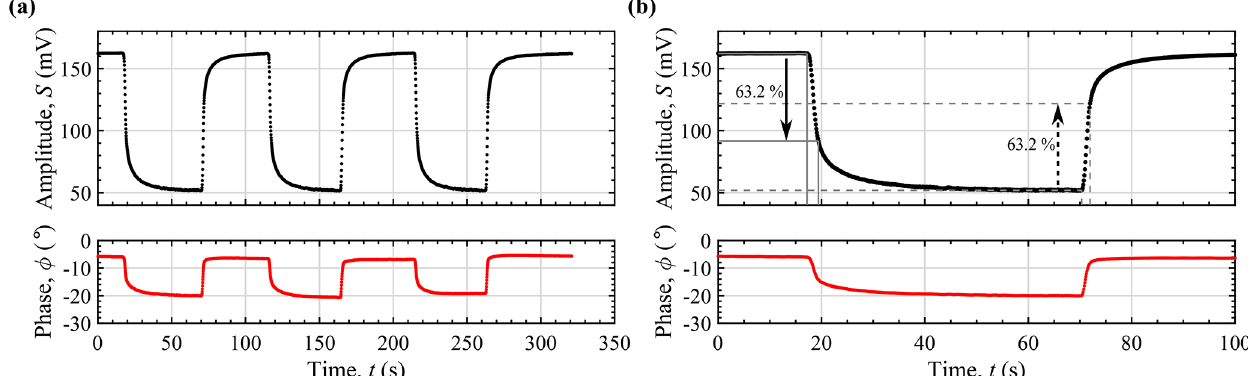
Figure D1. (a) Background corrected photoacoustic amplitude and phase during a sequence of recovery and response time measurements, performed by alternately sampling humidified and ambient air with water vapor mole fractions of 18750 and 5570ppm, respectively. A lock-in integration time of 1s was used. (b) First segment of (a) with indicated PA signal levels used for the determination of the 63 . 2% response and recovery